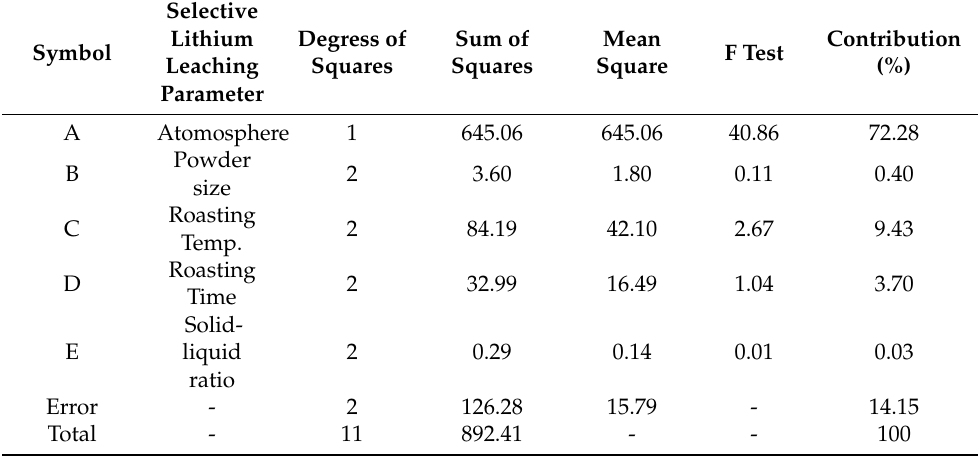
Table 6. Results of the ANOVA for selective lithium leaching ratio.